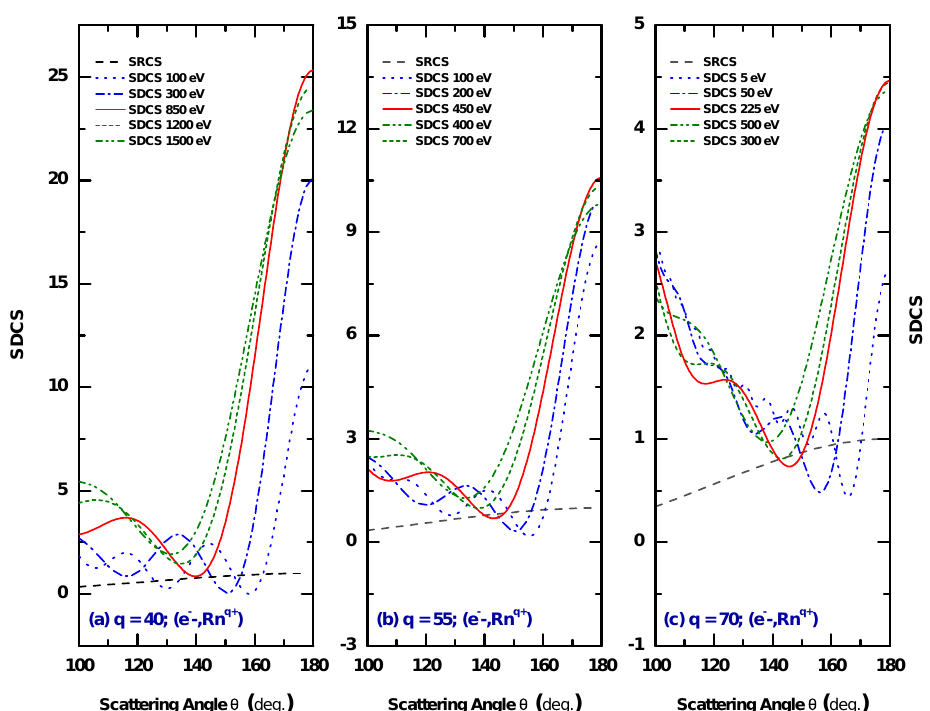
Figure 31. Angular variation of the scaled differential cross section for e − -Rn q + scattering at different energies for the ionicities q = ( a ) 40, ( b ) 55 and ( c ) 70. Furthermore, are present the scaled Rutherford cross sections for the same scattering